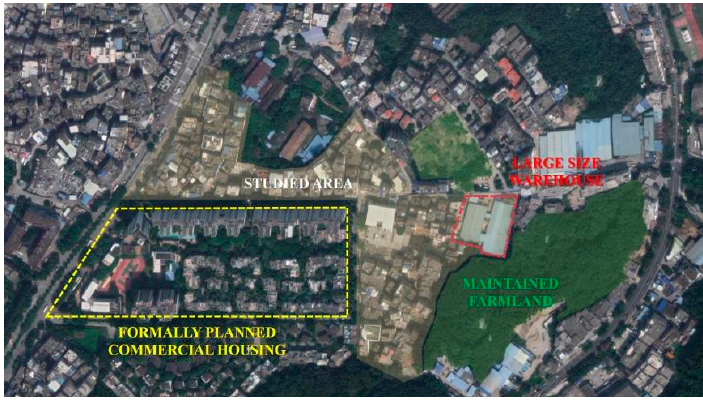
Figure 2. Map of Dayuan Village and the study area. Source: Tencent Map.